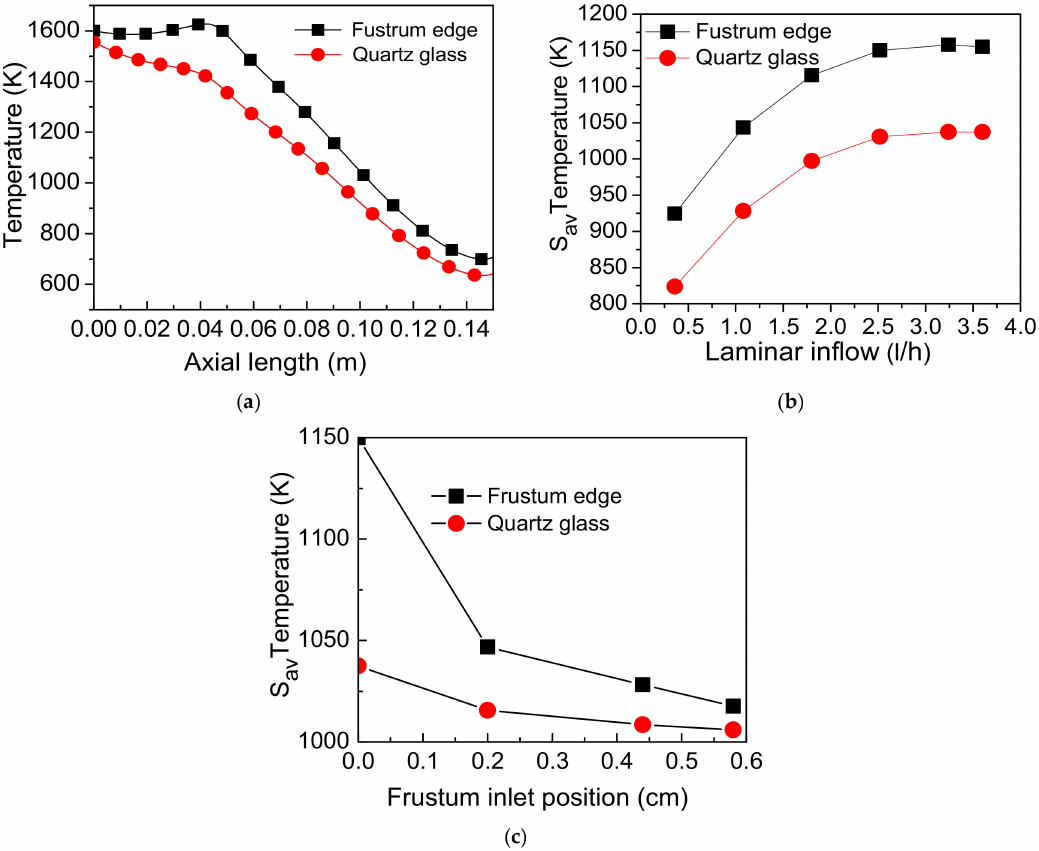
Figure 5. Temperature distribution in the cavity along axial length at 150 kW / m 2 , 1 atm and 1.8 1 / h laminar inflow rate: ( a ) Temperature distribution flux applied on frustum edge and quartz edge; ( b ) (S av ) temperature at di ff erent laminar inflow rates; ( c ) (S av ) temperature at di ff erent gas inlet positions of radiation flux applied on frustum and quartz glass